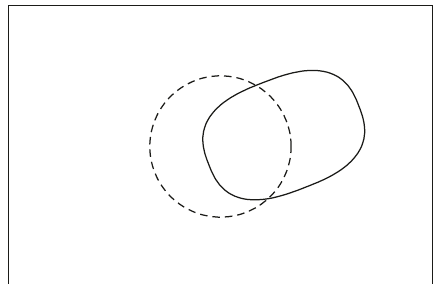
Figure 13: Shapes of Model 3 before and after optimization.